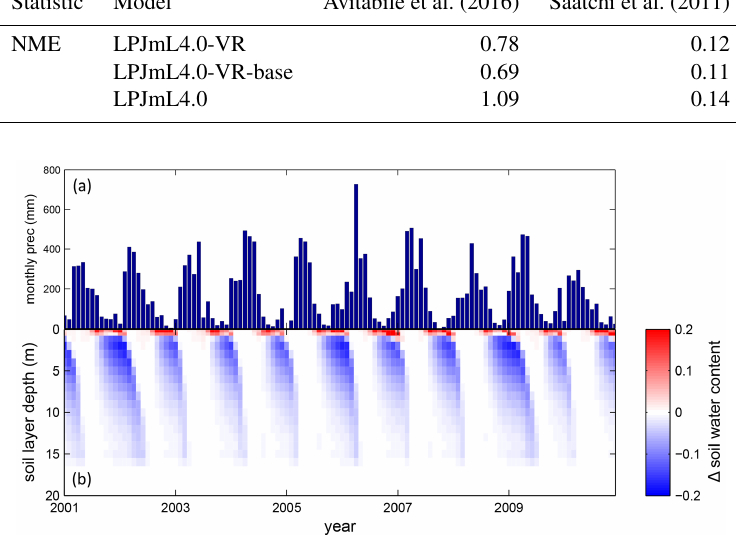
Figure B11. Difference in soil water reaction to seasonal precipitation between LPJmL4.0-VR-base and LPJmL4.0-VR at FLUXNET site STM_KM67. (a) Mean monthly precipitation input from CRU for 2001–2010. (b) Difference in monthly relative soil water content between LPJmL4.0-VR-base and LPJmL4.0-VR forced with CRU climate for 2001–2010. The underlying model output variable “soil water content” of each model version is a number between 0 and 1 depicting the relative water saturation of the soil. Blue colours denote lower soil water